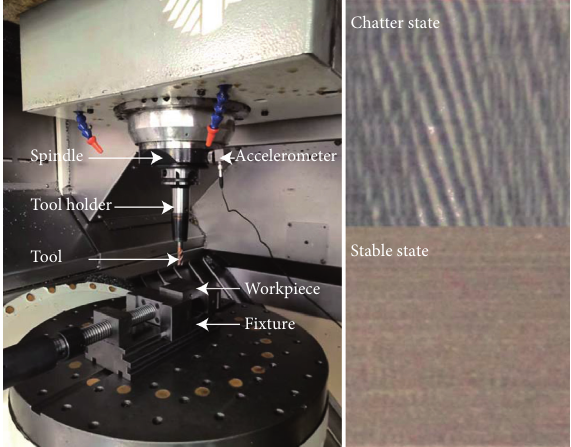
Figure 4: Experimental setup and machining surface of parts (chatter state and its cutting conditions: spindle speed 7500r/min, axial depth of cut 0.4mm, radial depth of cut 0.1mm, and feed rate 0.1mm/rev; stable state and its cutting conditions: spindle speed 6000r/min, axial depth of cut 0.2mm, radial depth of cut 0.1mm, and feed rate